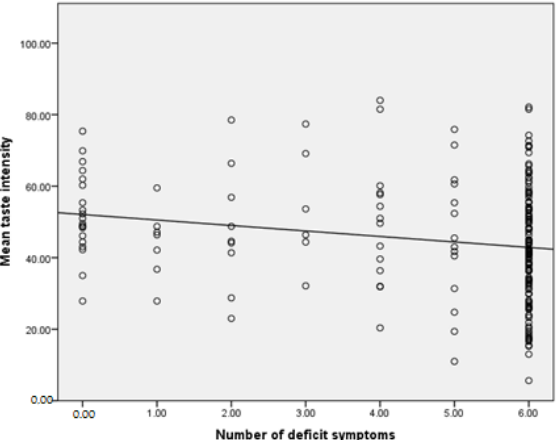
Figure 1. Correlation between mean taste intensity and number of deficit symptoms.